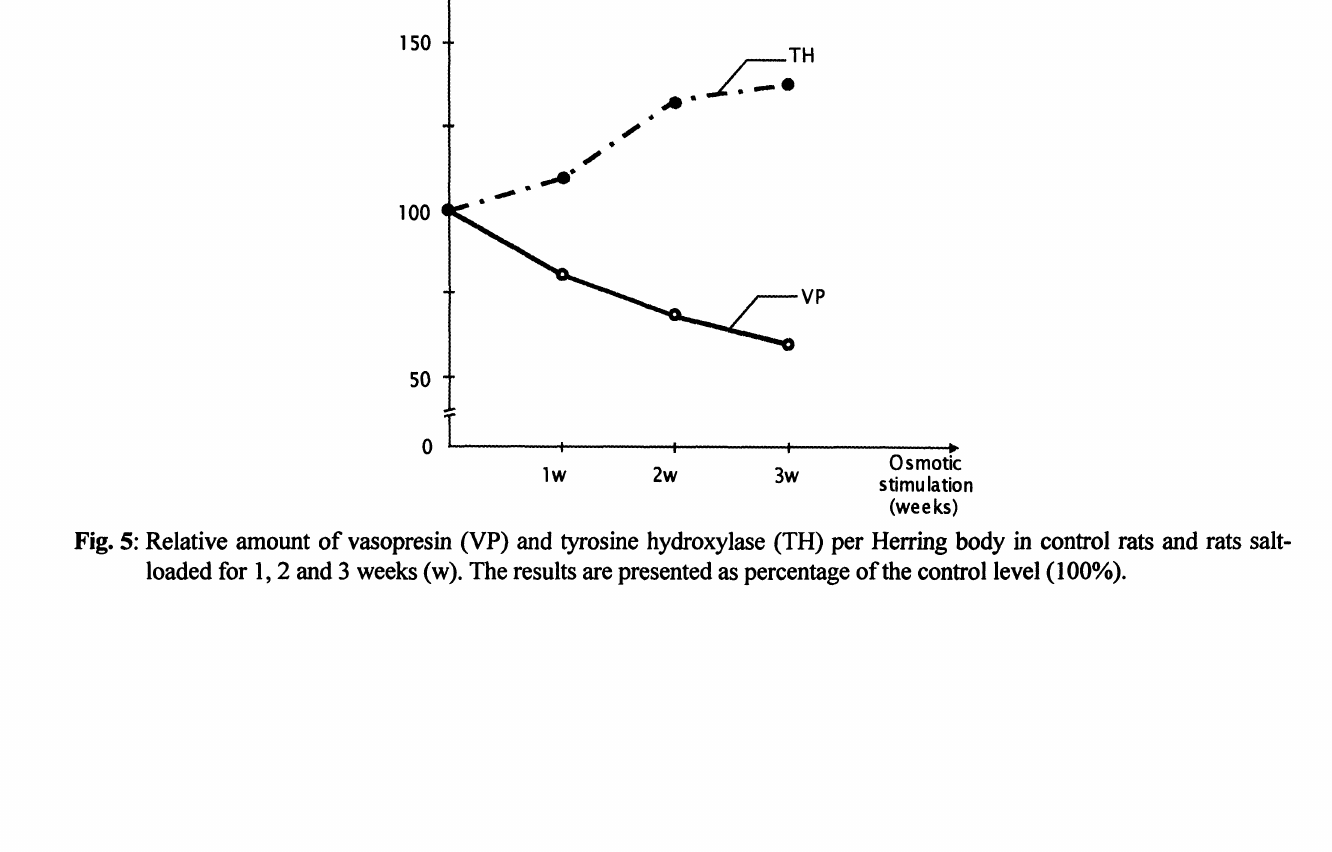
Fig. 5: Relative amount of vasopresin (VP) and tyrosine hydroxylase (TH) per Herring body in control rats and rats salt- loaded for 1, 2 and 3 weeks (w). The results are presented as percentage ofthe control level